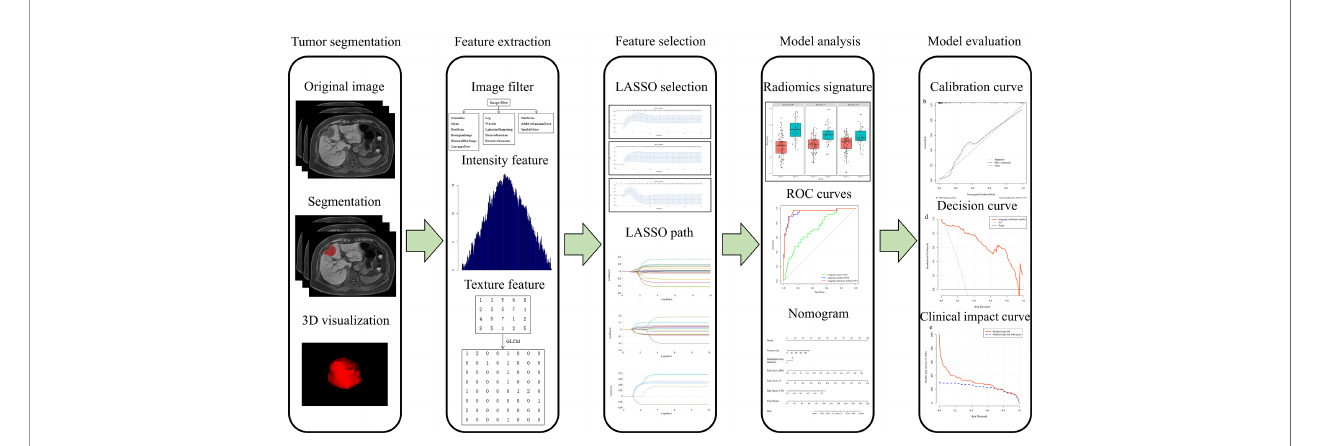
FIGURE 2 | Study fl owchart of the